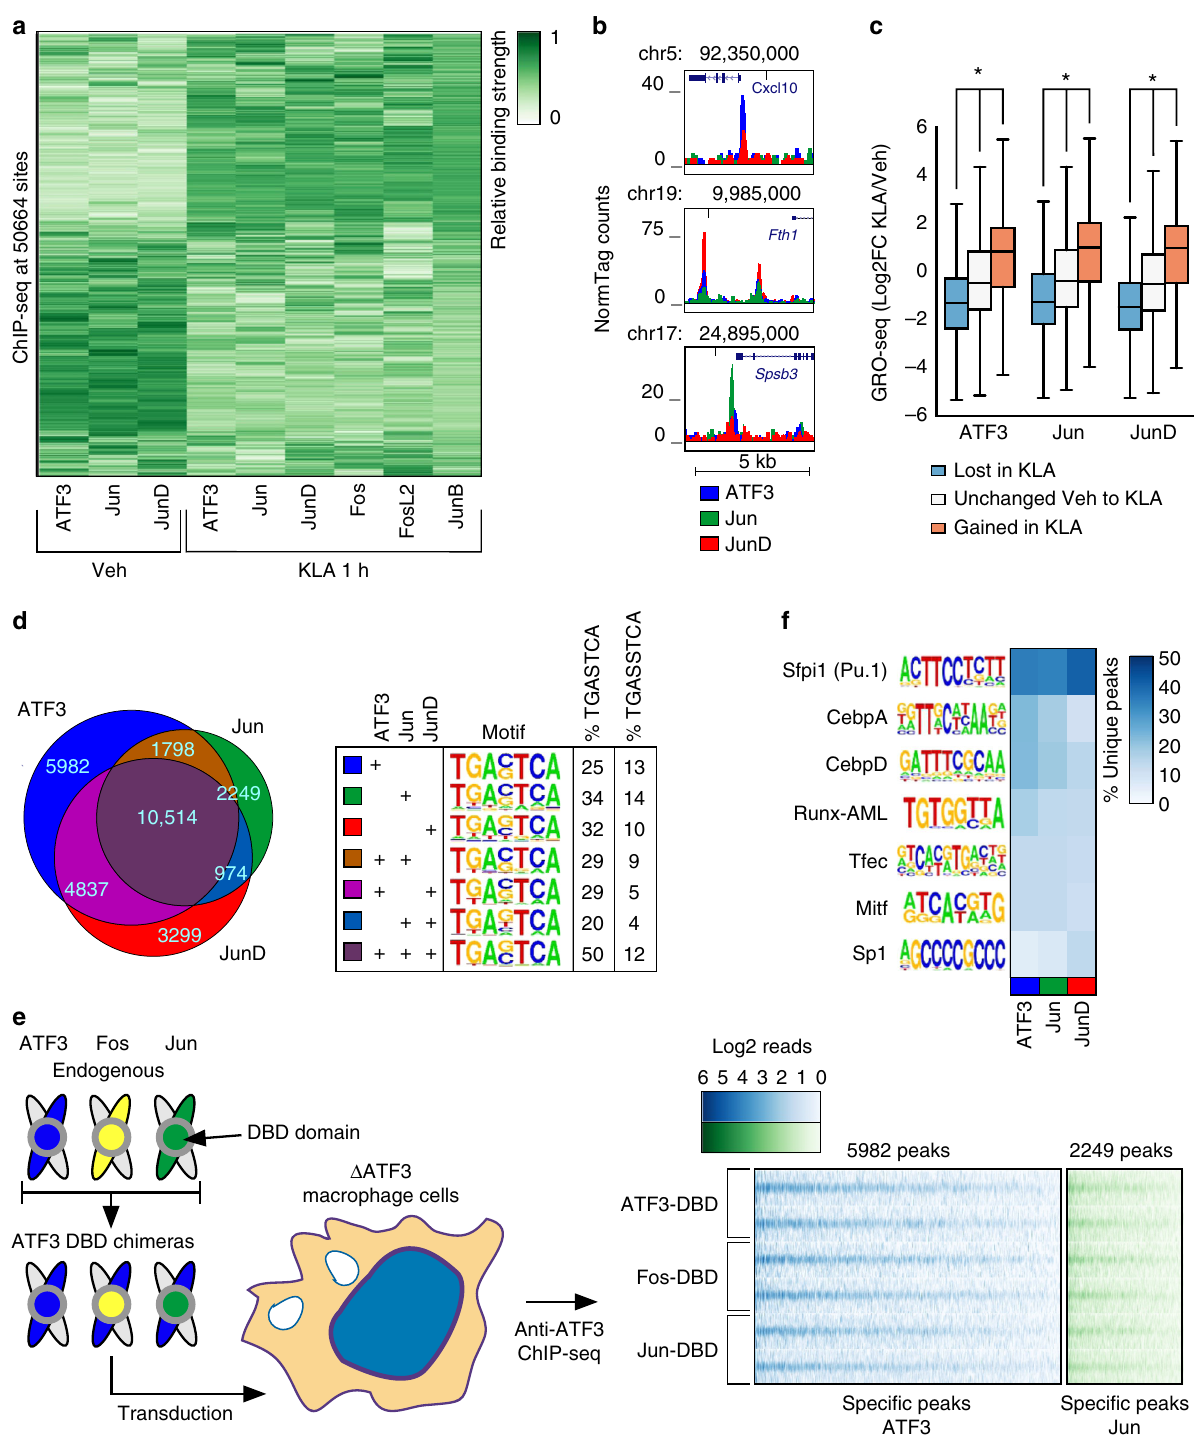
Fig. 2 AP-1 monomers bind at unique loci that cannot be explained by differences in the DNA binding domain. a Hierarchical clustering of the relative strength of binding of each monomer at all AP-1 binding sites in Vehicle and 1-h Kdo2 lipid A (KLA) treatment conditions. b Representative browser shots of ChIP-seq peaks for Veh-speci fi c monomers ATF3, Jun, and JunD. c Genome run-on sequencing at sites where ATF3, Jun, and JunD were lost, gained, or unchanged after 1 h KLA treatment. d Venn diagram of ATF3, Jun, and JunD peaks in Vehicle (left) and table indicating the de novo AP-1 motifs found in each subset of peaks and the percent of peaks in each subset that contain one of the two AP-1 motif variants (right). e Binding strength comparison of ATF3 chimeras. The ATF3 DNA binding domain (blue) is replaced by the DNA binding domains of Fos (yellow) or Jun (green) and then transduced into ATF3-de fi cient immortalized bone marrow-derived macrophage cells with a lentivirus vector (left). The binding of each chimera is shown as a heatmap of ChIP-seq tags centered on ATF3 chimera binding sites (replicates indicated in separate rows) that were found to be speci fi c for ATF3 (blue) or Jun binding in thioglycollate elicited macrophages (green). f Heatmap showing the percent of unique binding sites for each monomer that contain a de novo motif calculated from each set of unique peaks. * indicates p < 0.01, for all comparisons between Lost in KLA, Unchanged Veh to KLA, and Gained in KLA for each AP-1 family member, independent